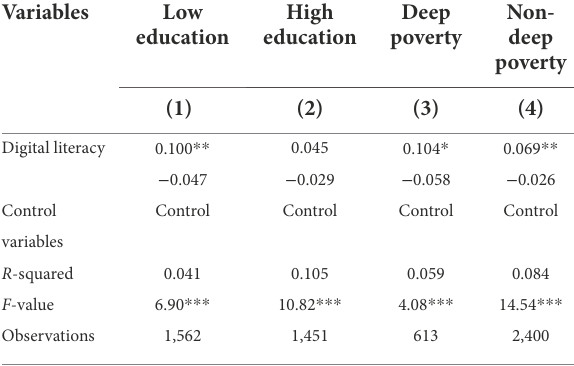
TABLE 5 Estimation results of group